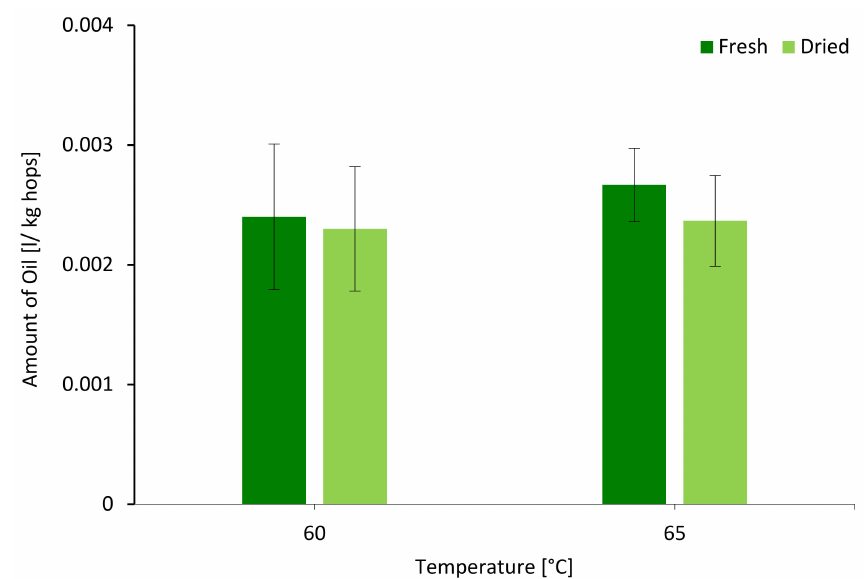
Figure 8. Amount of oil in L / kg hops extracted for samples extracted at 0 min and 210 min for hop cones dried at 60 ◦ C and 65 ◦ C at 0.35 m / s.